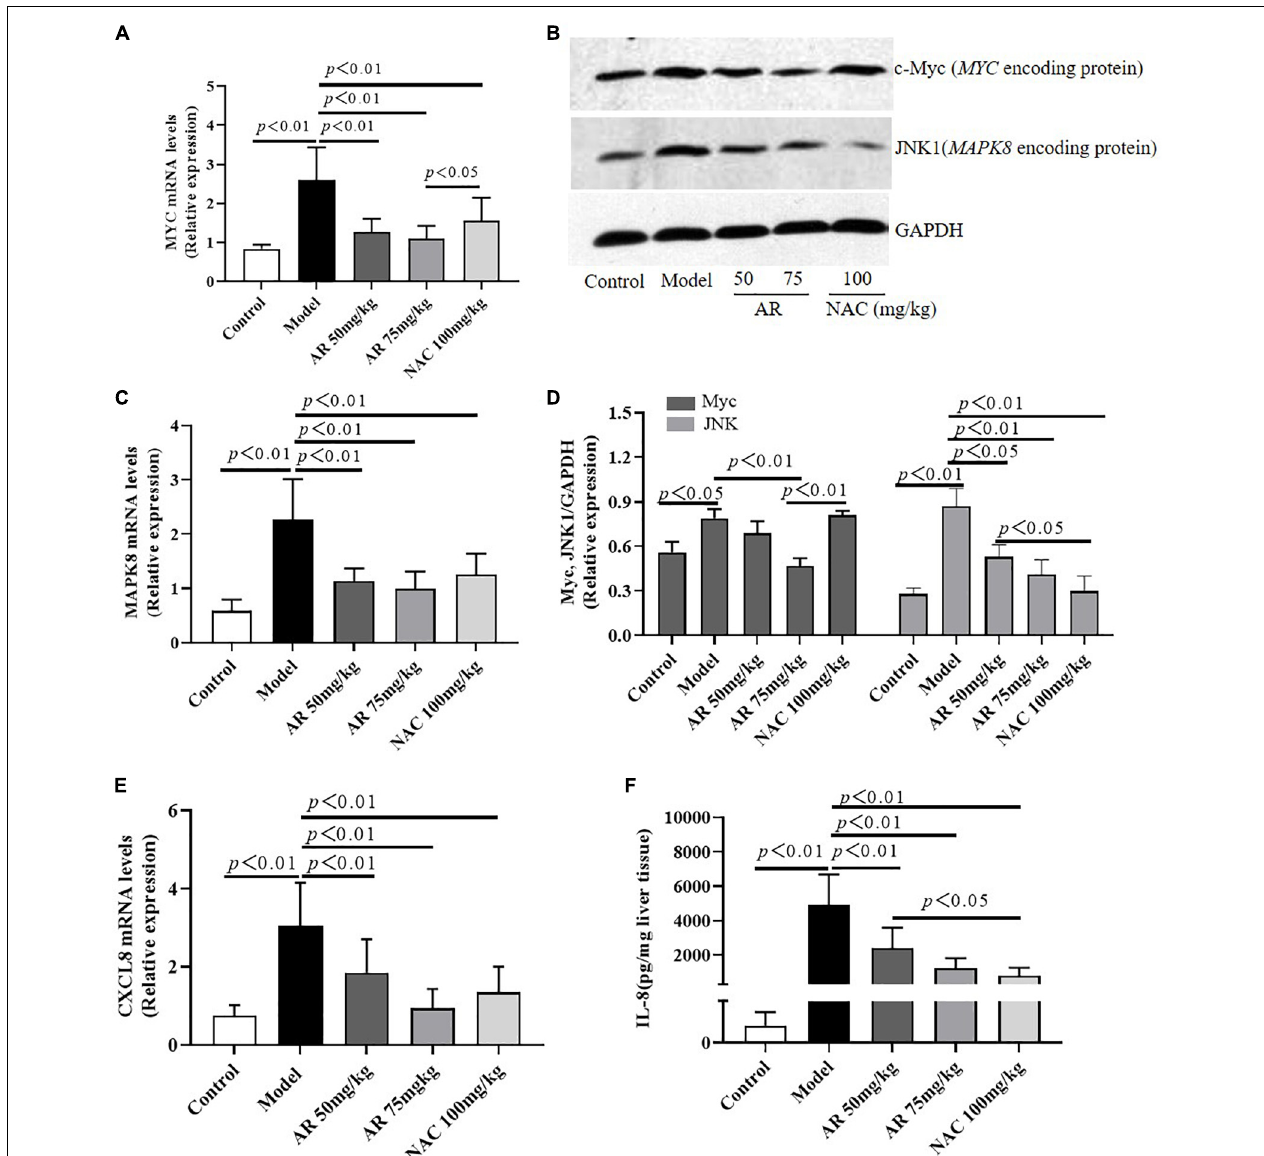
FIGURE 7 | Astragali Radix treatment inhibits the expressions of MYC (c-Myc), MAPK8 (JNK1) and CXCL8 (IL-8) in APAP-induced liver injury. Mice were administered intragastrically with AR (50, 75 mg/kg body weight) or N -acetyl- L -cysteine (NAC, 100 mg/kg body weight) once a day for three consecutive days. Then APAP was dissolved in 5% carboxymethylcellulose sodium in water and given intragastrically with 350 mg/kg body weight as noted in the protocol. Twelve hours after APAP administration, all mice were sacrificed. The mRNA levels of MYC (A) , MAPK8 (C) , and CXCL8 (E) in liver tissues were assayed by qPCR. (B) Western blot analyses for the expressions of c-Myc and JNK1 corresponding to genes MYC and MAPK8 in hepatic tissues and (D) graphic presentation of the relative expressions of c-Myc and JNK1. (E) The encoding protein IL-8 corresponding to gene CXCL8 were detected by ELISA. Significantly increased c-Myc, JNK1, and IL-8 expressions were observed in mice of the model group. In contrast, AR treatment attenuated APAP-induced upregulation of c-Myc, JNK1, and IL-8 expressions in dose-dependent. NAC treatment downregulated JNK1 and IL-8 expressions, not affected c-Myc